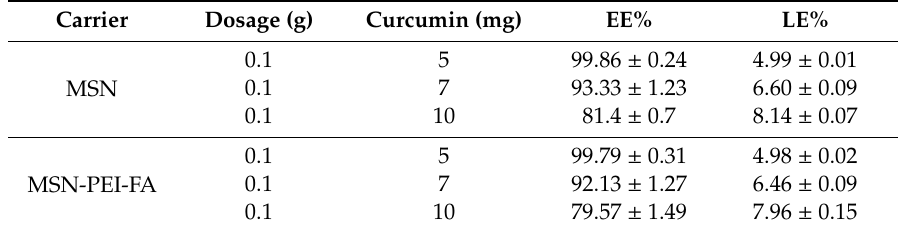
Table 2. The e ff ect of di ff erent curcumin dosages on encapsulation e ffi ciency and loading e ffi ciency.